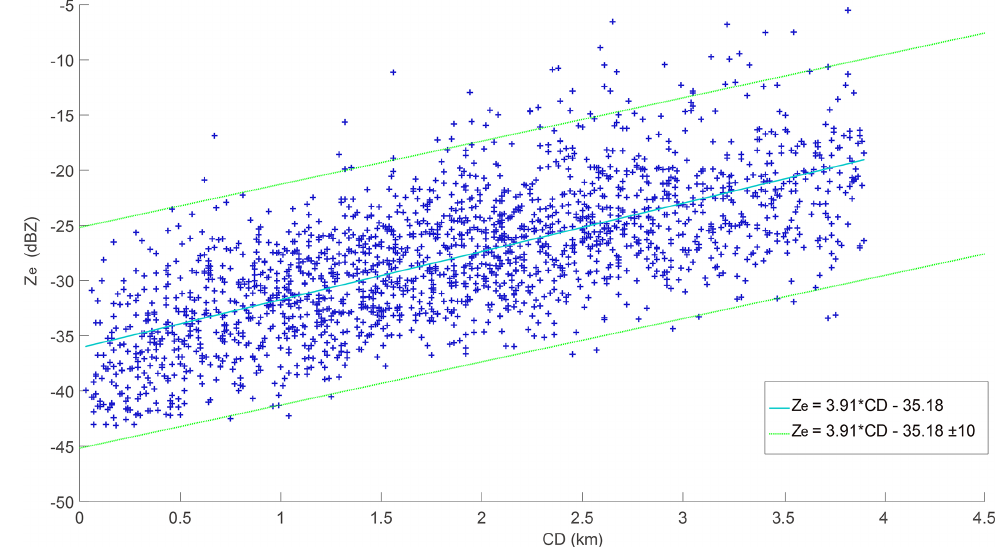
Figure 7. The mean reflectivity of ice clouds as a function of cloud depth